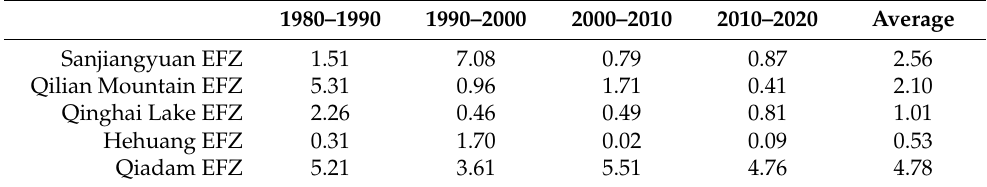
Table 4. Elasticity of ESVs with respect to LUCCs of five ecological function zones in Qing- hai